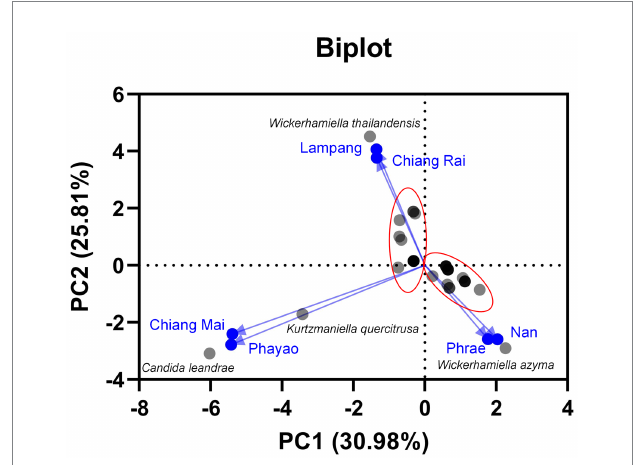
FIGURE 7 Principal component analyses of yeast species based on the relative abundance of yeast species in tea flower samples, and